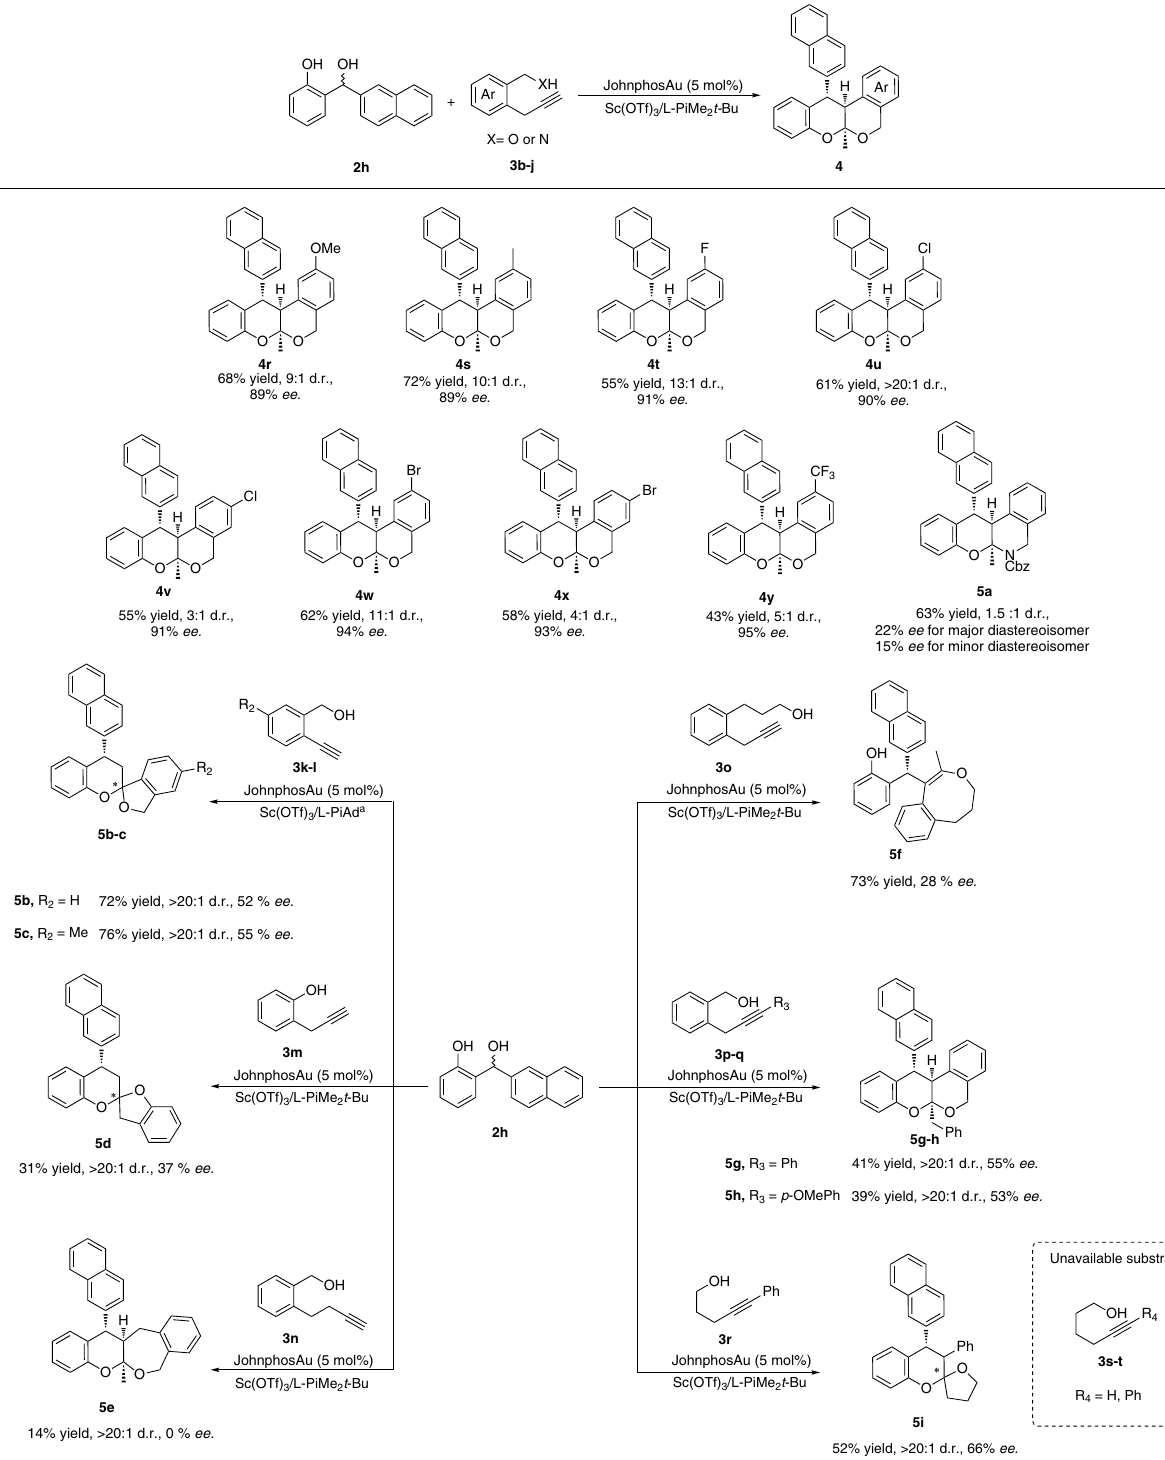
Fig. 4 Substrates scope of α -propargyl benzyl alcohols. Unless otherwise noted, all reactions were carried out on a 0.2 mmol scale with 1 eq 2h , 1.2 eq 3 , 10 mol% of Sc(OTf) 3 , 11 mol% of L-PiMe 2 t -Bu and 5 mol% of JohnphosAu in DCM (2.0 mL) under 6 °C. Isolated yield for major diastereomer. ee was determined by chiral HPLC. D.r. was detected by crude 1 H-NMR. a 11 mol% of L-PiAd as